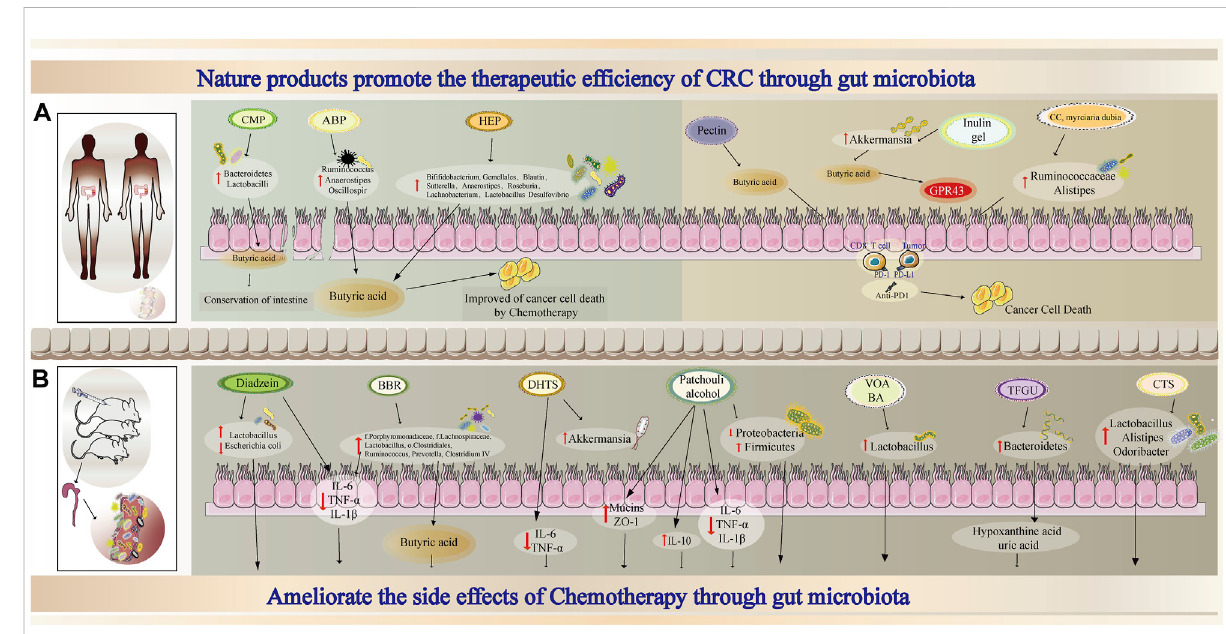
FIGURE 2 Proposed mechanism combined nature products and chemotherapy or immunotherapy through gut microbiota in oncotherapy (A) The combination of nature products and chemotherapy or immunotherapy enhances tumor therapeutic effect through gut microbiota (B) Nature products ameliorate the side effects of chemotherapy through gut